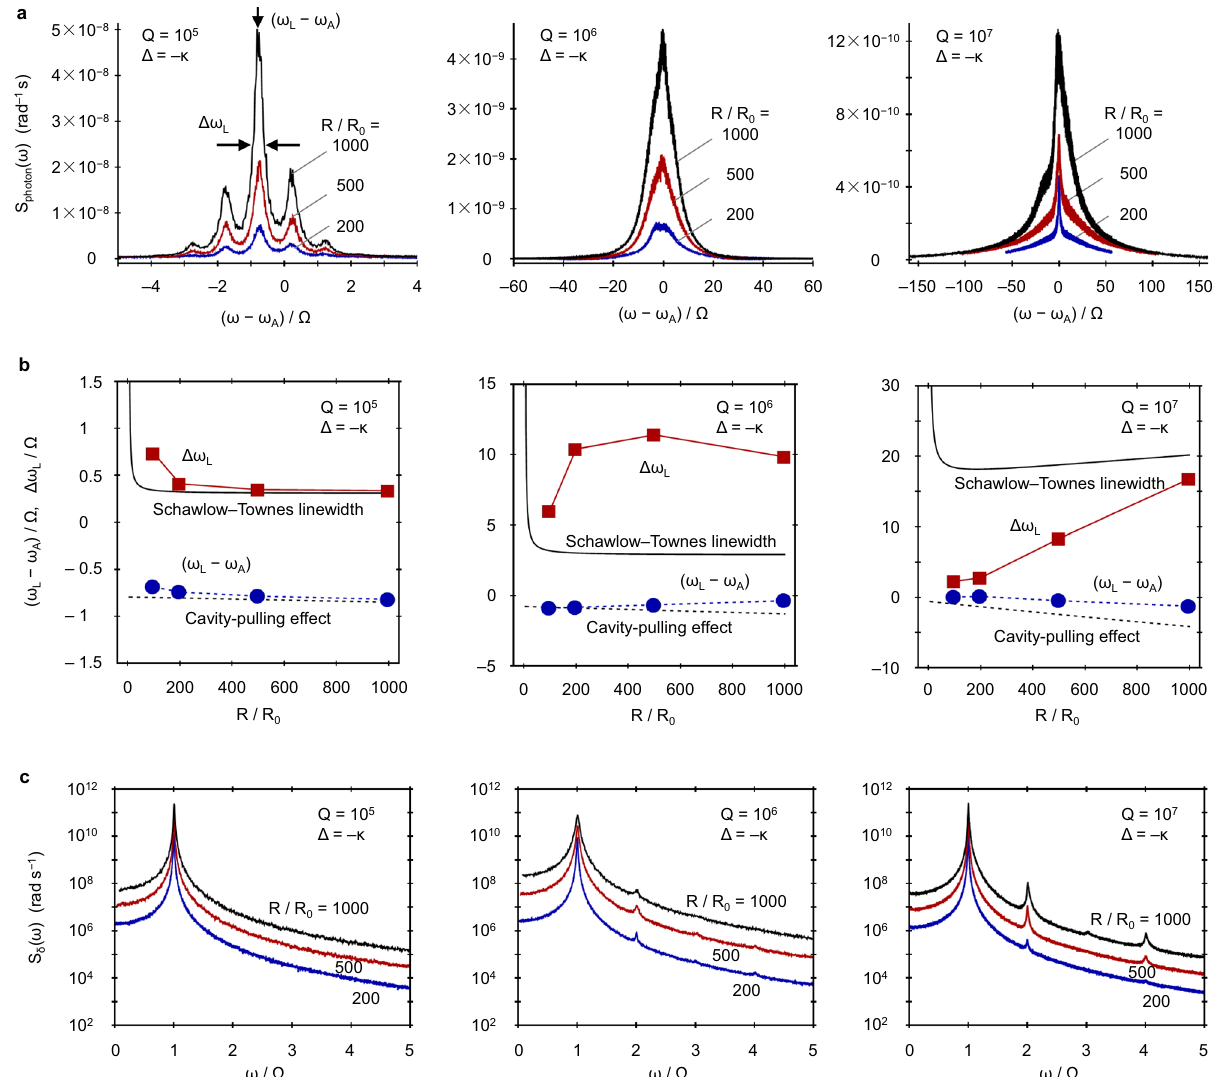
Fig. 2 Power spectral densities of laser fi eld and mechanical oscillation. a Numerically simulated spectrum S photon ð ω Þ of the intracavity light fi eld for different cavity Q factors and pump rates R . The atom – cavity detuning is set at Δ ¼ (cid:2) κ with the cavity loss rate κ , and R 0 denotes the minimum pump threshold. At Δ ¼ (cid:2) κ , the optomechanical laser has stable steady-state solutions for different Q and R . The laser frequency ω L is shifted from the atomic transition frequency ω A and the laser linewidth (i.e. full width half maximum) is Δ ω L . The mechanical oscillation frequency Ω is chosen as the frequency unit. b Dependence of laser frequency shift ð ω L (cid:2) ω A Þ and linewidth Δ ω L on the pump rate R for different Q factors with Δ ¼ (cid:2) κ . Symbols corresponds to the numerical results. The curves derived from the cavity pulling effect and Schawlow – Townes formula are also plotted for comparison. c Numerically simulated spectrum S δ ð ω Þ of the mechanical-displacement-induced detuning δ ð t Þ for different Q and R with Δ ¼ (cid:2) κ